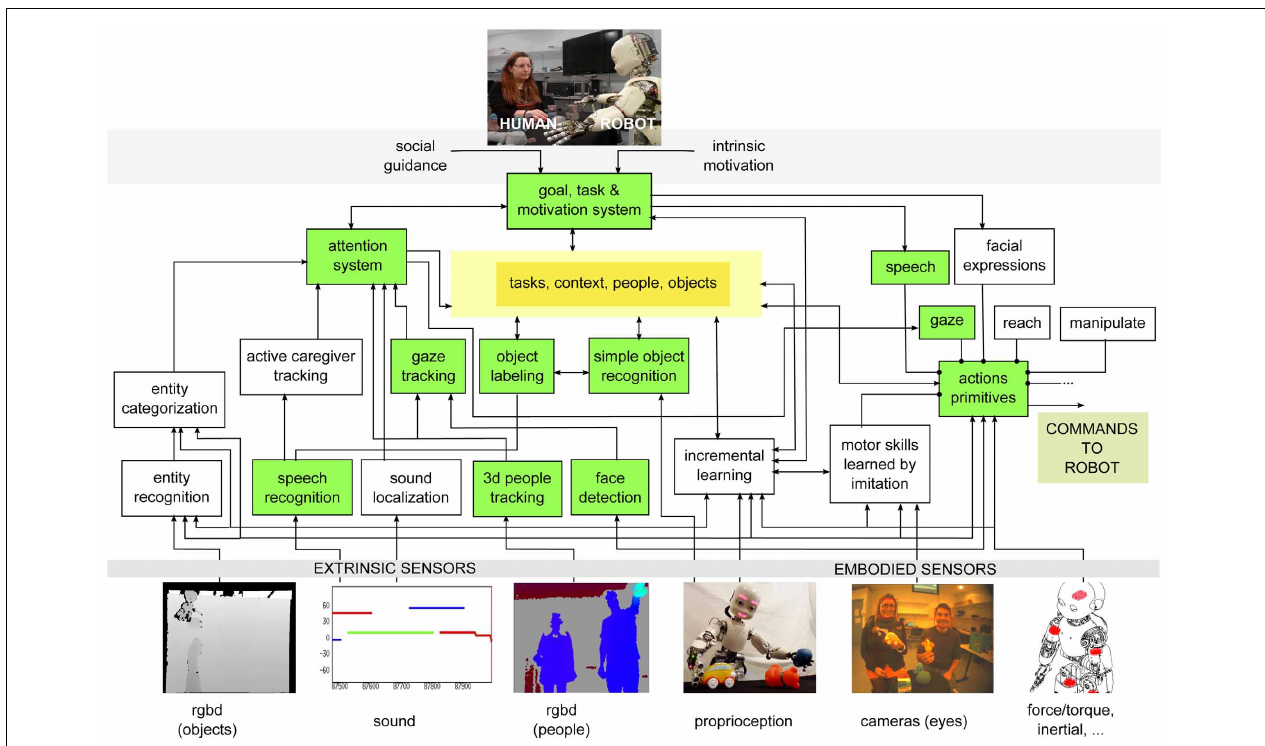
FIGURE 3 | iCub’s cognitive architecture (from Ivaldi et al., 2013) enriched with the new modules. In green, the modules that have been used for the experiment of this paper.